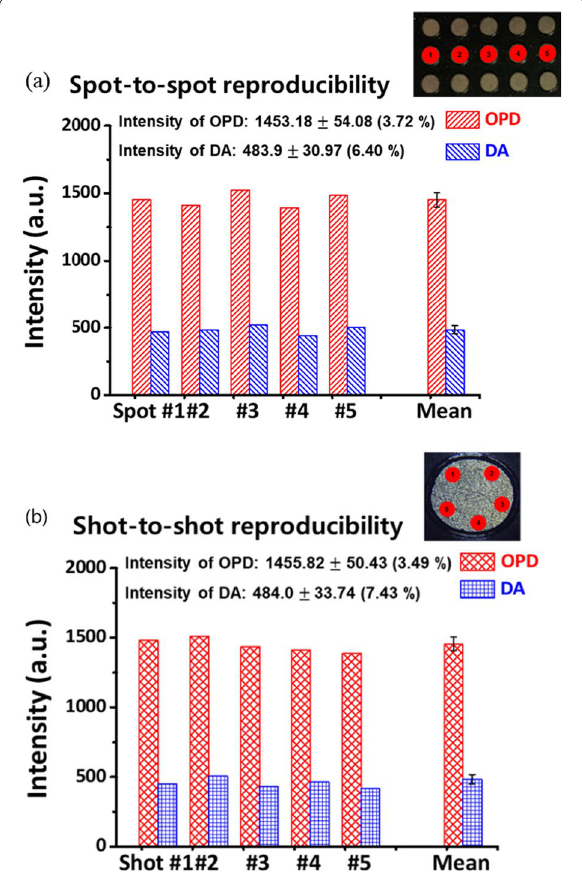
Fig. 2 Reproducibility of a inter‑spot measurements for five independent sample spots ( n measurements for five independent sample positions ( n using the TiO 2 nanowire